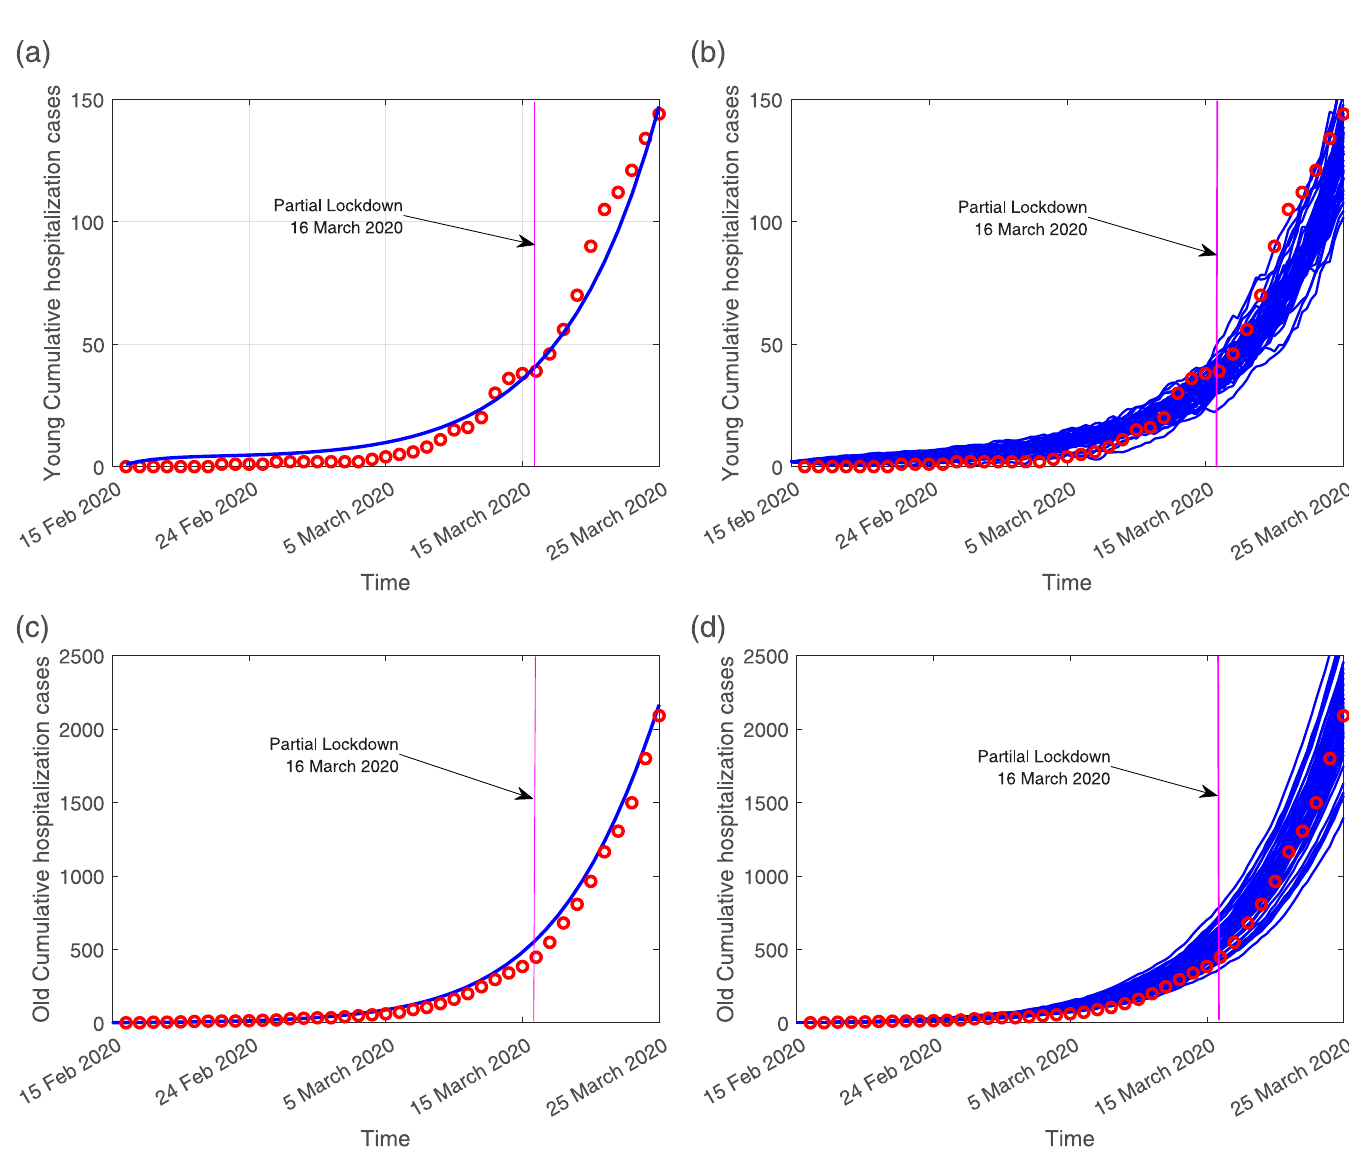
Fig 3. On the left hand side, the deterministic model curve (blue line) and on the right hand side, the stochastic model realizations (in blue), fitting the cumulative empirical data referring to hospital admissions (red dots). In (a) and in (b) data matching with model simulations for the young (0–39 years of age) age group. In (c) and (d) data matching with model simulations for the old (40 years and older) age